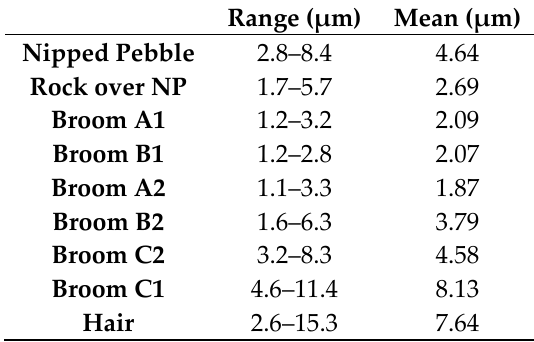
Table 1. Summary of the Range ( μ m) and Mean ( μ m) scratch depths in the ice from the noted